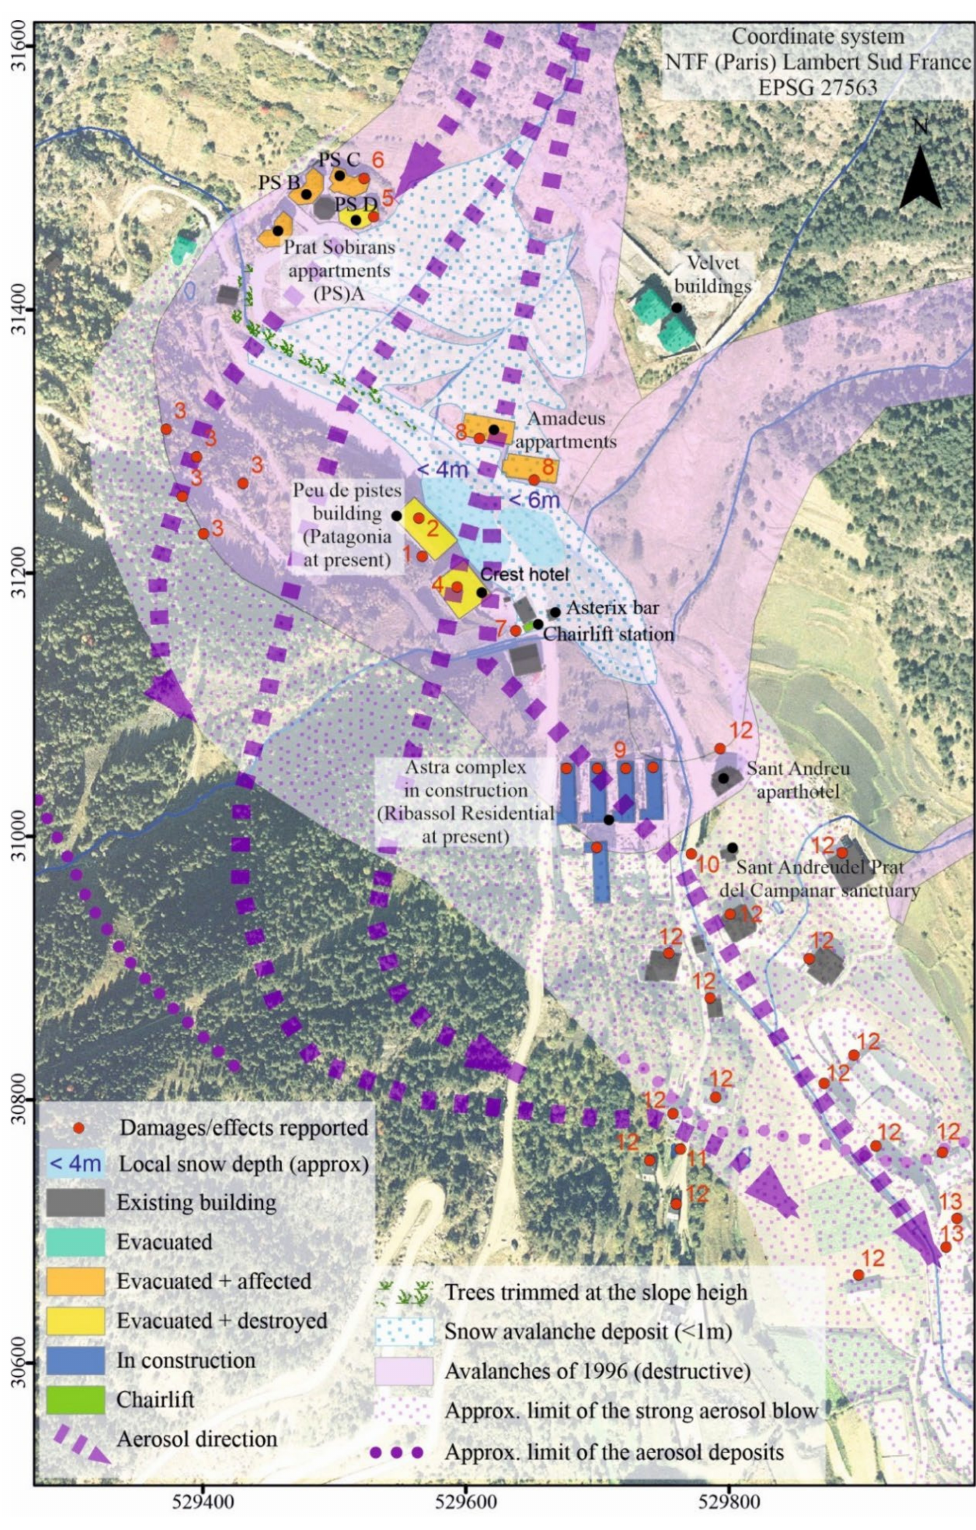
Figure 9. Map of the LFd’A avalanche run-out. In violet, the main zone with destruction; the purple dotted plot area corresponds to the strong aerosol blow a ff ected area, and the violet thick dotted line the limit where dirt (pine needles and fragments of branches, small pieces of furniture, etc.) were found. In purple arrows, the main trajectory of the avalanche. The numbers related to the red dots represent the damage and evidence of elements displaced by the avalanche and are explained in Table